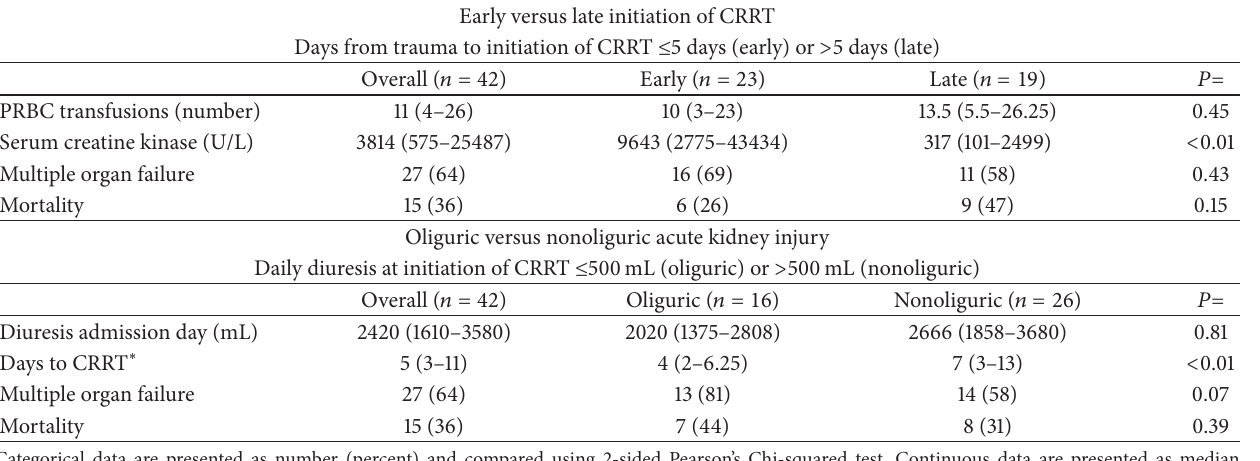
Table 3: Subgroups analyses of trauma patients with acute kidney injury treated with continuous renal replacement therapy ( 𝑛 = 42 ). Early versus late initiation of